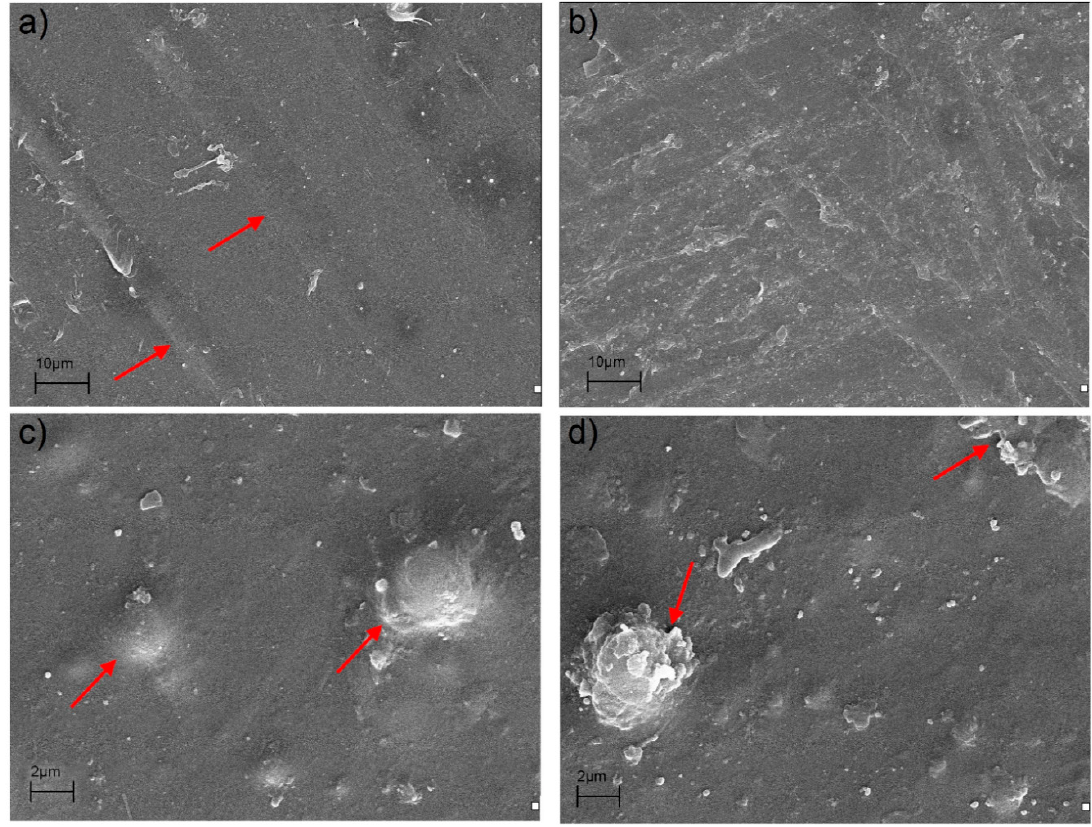
Figure 5. SEM images of composite films: ( a ) PLA, ( b ) dPLA, ( c ) PLA/5:1, and ( d ) dPLA/5:1.